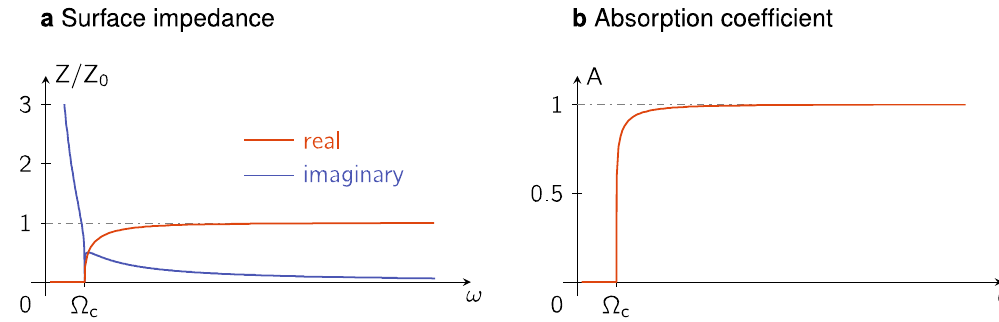
Figure 1. ( a ) A plot of the normalized impedance as a function of frequency, calculated from Equation (11). Here, the imaginary part of the impedance, denoted by the blue line, is seen to decay quickly, as expected from the oscillatory nature of the integrant in Equation (8). The real part of the impedance approaches the target value in an exponential fashion. ( b ) The calculated absorption coefficient is seen to approach 1 in an exponential fashion. At frequencies close to the cutoff frequency, the effect of the imaginary part can be significant, but its influence decreases quickly with increasing frequency.